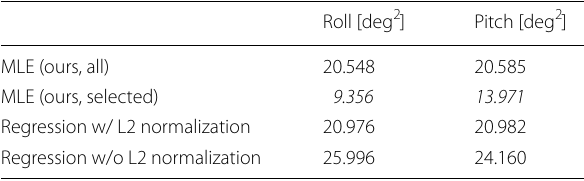
Table 10 Variance of estimated attitude error in real world